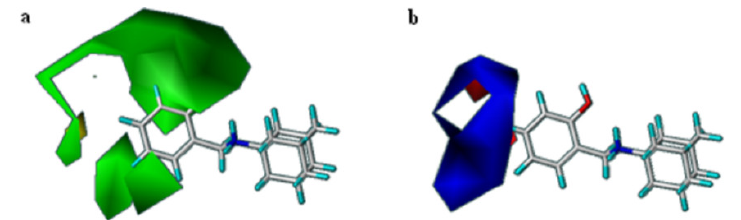
Figure 2. CoMFA StDev*Coeff contour maps around the active compound 29: ( a ) for steric field (green: bulky groups are favored; yellow: bulky groups are disfavored) and ( b ) for electrostatic field (blue: electropositive groups are favored; red: electronegative groups are favored).